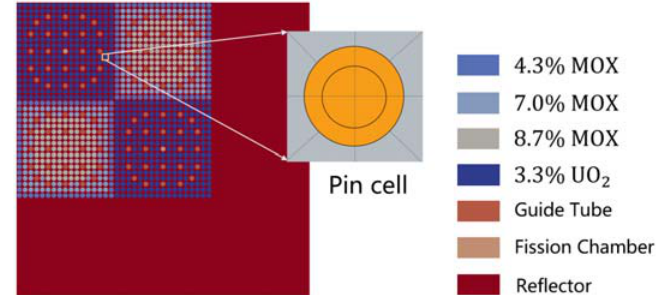
Figure 2: Geometry and fuel configuration of the 2D C5G7 problem.